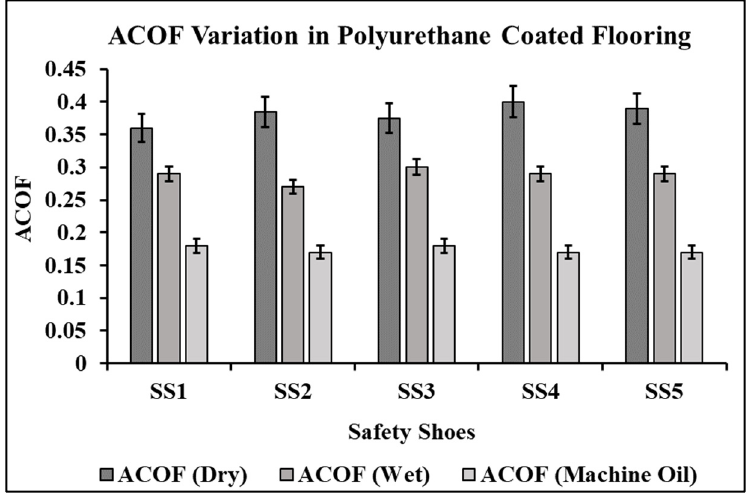
Figure 7. ACOF variation in polyurethane-coated flooring across dry, wet, and machine oil slip setting.